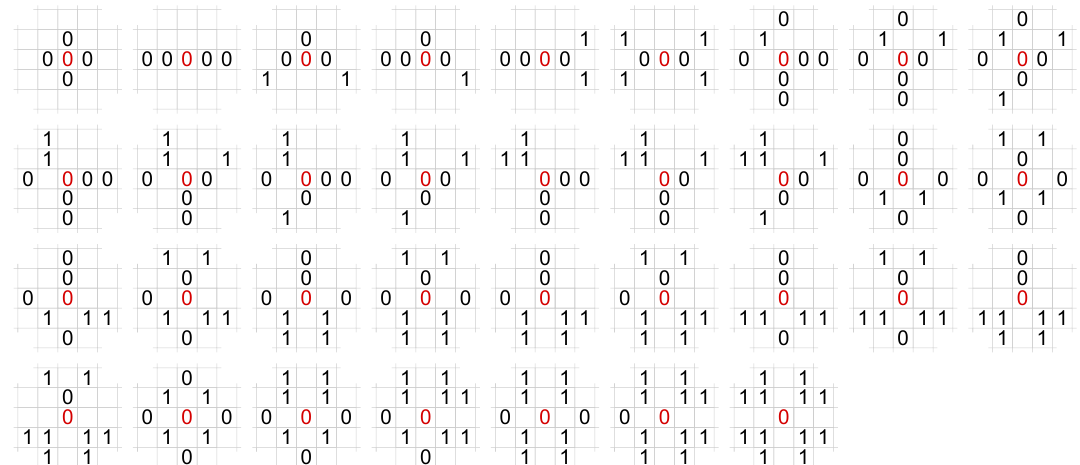
Figure 21: Local configurations of spins (in black) that are sufficient for the central spin (red) to not be immediately flippable under the action of the Hamiltonian ˆ H ′ , i.e., rectangular interactions 1 × 1,1 × 2,2 × 1. All possible such configurations (330 in total) can be obtained from the ones presented in the figure by applying all possible combinations of C and C rotations, mirror reflections about the horizontal, vertical 4 2 and two diagonal (at 45°) lines going through the central spin, as well as (cid:90)